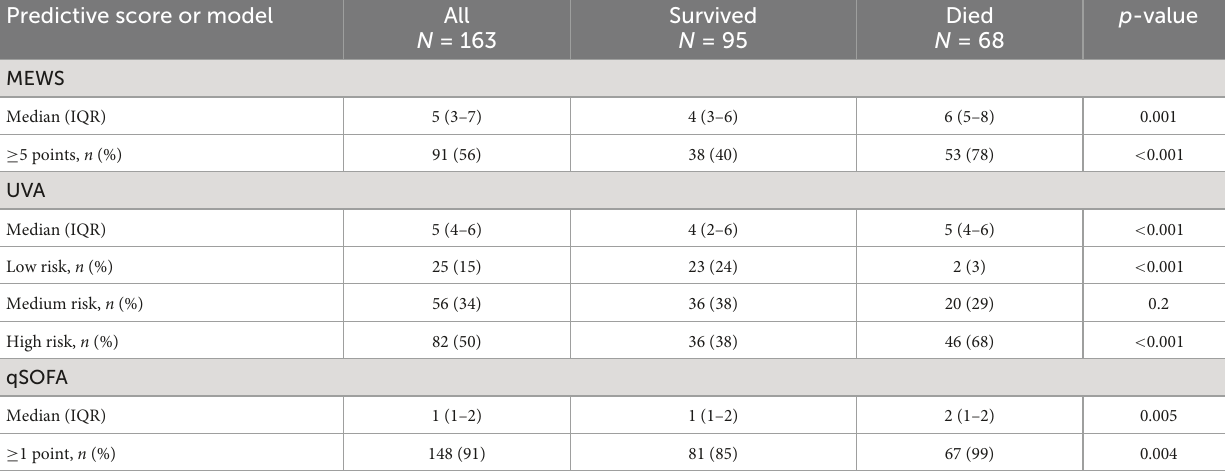
TABLE 3 Distribution of mortality scores and association with hospital mortality among patients with suspected infection. Predictive score or model